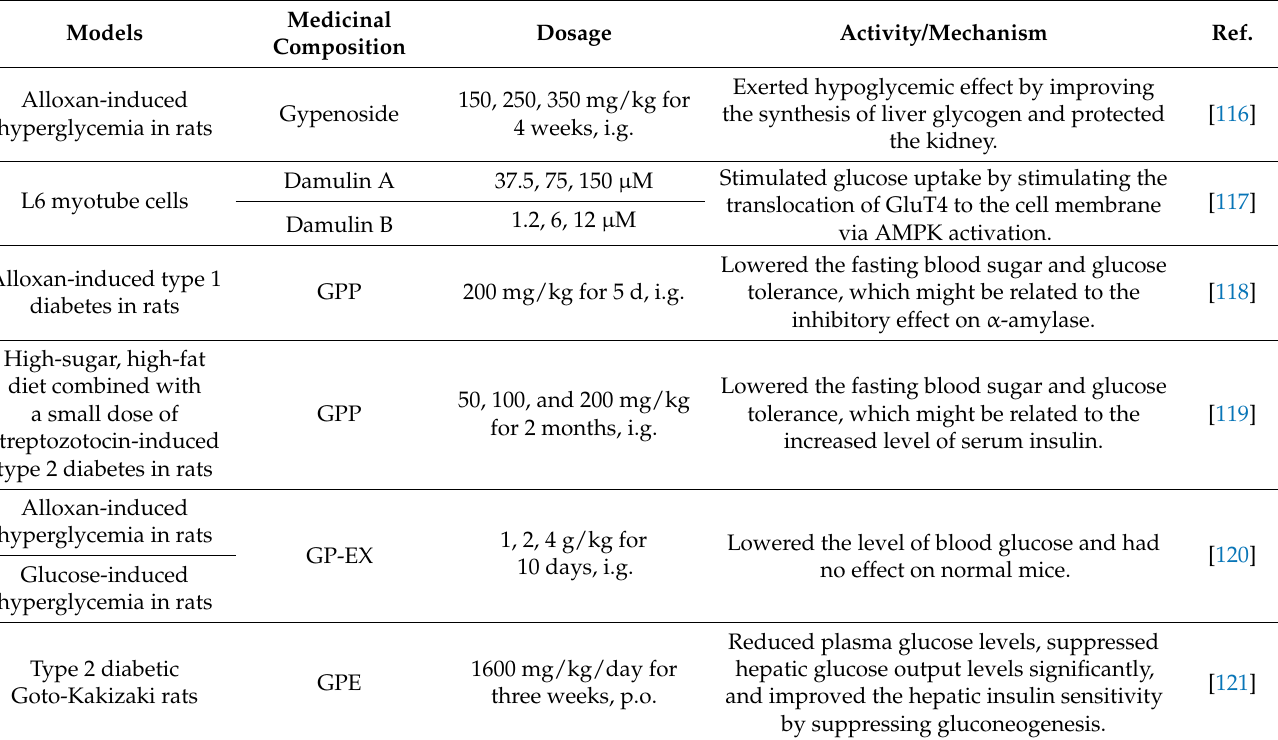
Table 6. Hypoglycemic effect of